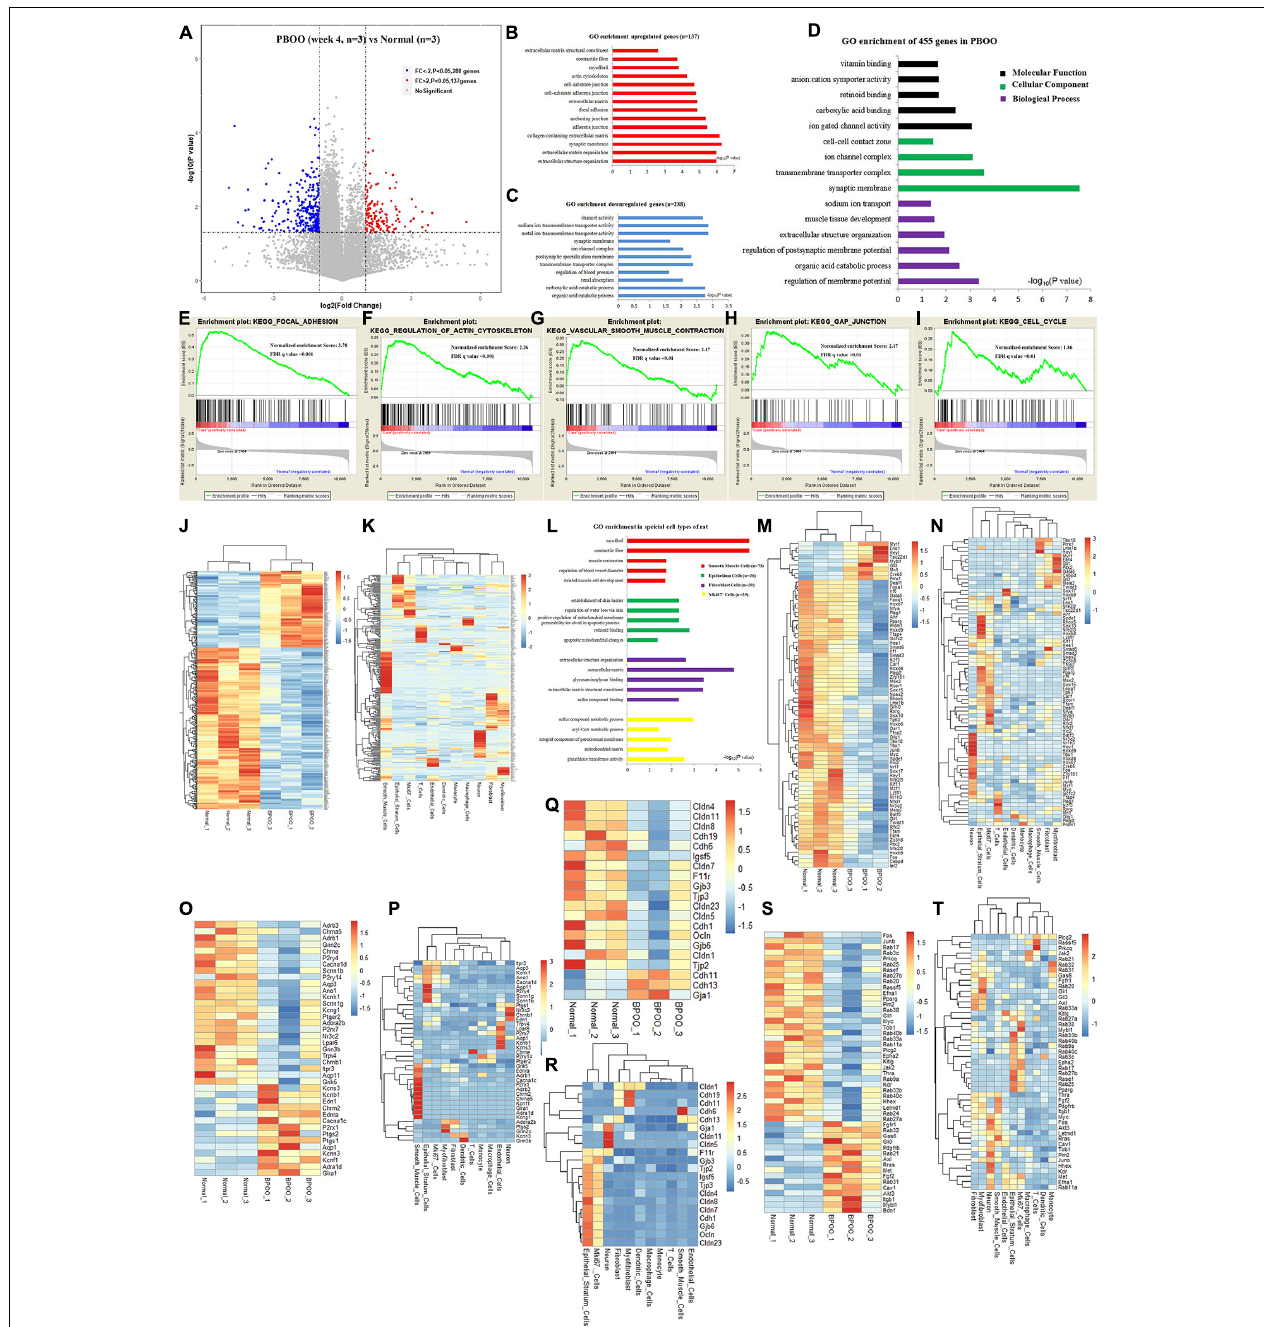
FIGURE 3 | RNA sequencing (RNA-seq) analysis comparing bladder tissues of week 4 PBOO and normal rat. Volcano plot (A) show 137 high expression genes (red color) and 288 low expression genes (blue color) in week 4 PBOO rat bladder tissues ( n = 3) compared with normal group ( n = 3). GO enrichment analysis of high expression genes ( n = 137) in PBOO rat bladder tissue (B) . GO enrichment analysis of low expression genes ( n = 288) in PBOO rat bladder tissue (C) . GO enrichment analysis of high and low expression genes ( n = 455) in PBOO rat bladder tissue (D) . GSEA analysis show five major KEGG pathway changes in PBOO rat bladder tissues compared normal groups (E–I) . Heatmap plot show 137 high expression and 288 low expression genes in two groups (J) . Heatmap plot show 455 abnormal expression genes mainly distributed in smooth muscle cells and interstitial cells of rat bladder (K) . GO enrichment analysis of abnormal expression genes in different cell type focus on different pathway (L) . Picking up 77 high and low expressed transcript factors (M) in PBOO rat bladder, and enrichment in different cell types in bladder tissues (N) . Picking up 40 high and low expressed ion channel genes (O) in PBOO rat bladder, and enrichment in different cell types in bladder tissues (P) . Picking up 20 high and low expressed cell connection genes (Q) in PBOO rat bladder, and enrichment in different cell types in bladder tissues (R) . Picking up 49 high and low expressed growth factors (S) in PBOO rat bladder, and enrichment in different cell types in bladder tissues (T) .